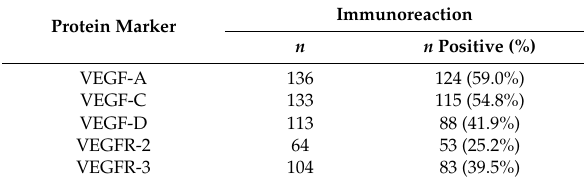
Table 2. Frequencies of positive VEGF family immunoreactions in the CRC LNM.